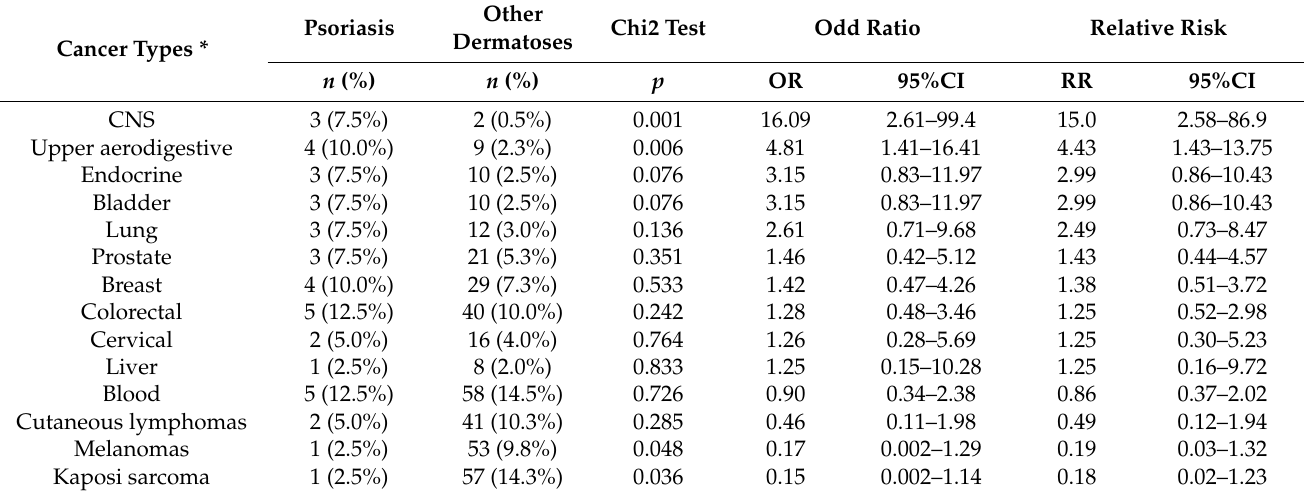
Table 2. Association of psoriasis with some cancer